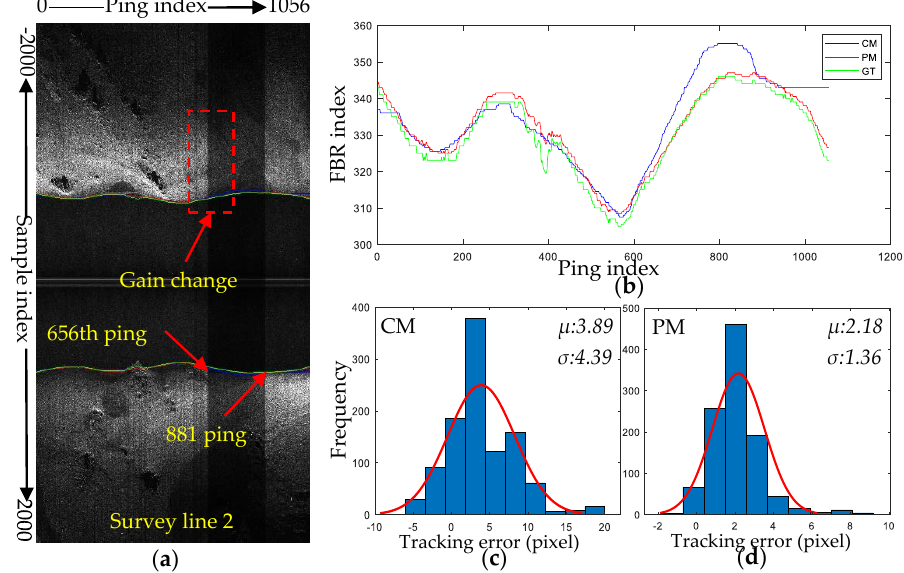
Figure 13. Bottom tracking experiment on the SSS data applied with varying unknown gains. ( a ) Waterfall image re-quantized from raw SSS data. ( b ) Averaged bottom tracking results of port and starboard with the tow methods. ( c , d ) Error distribution relative to the manual interpretation.